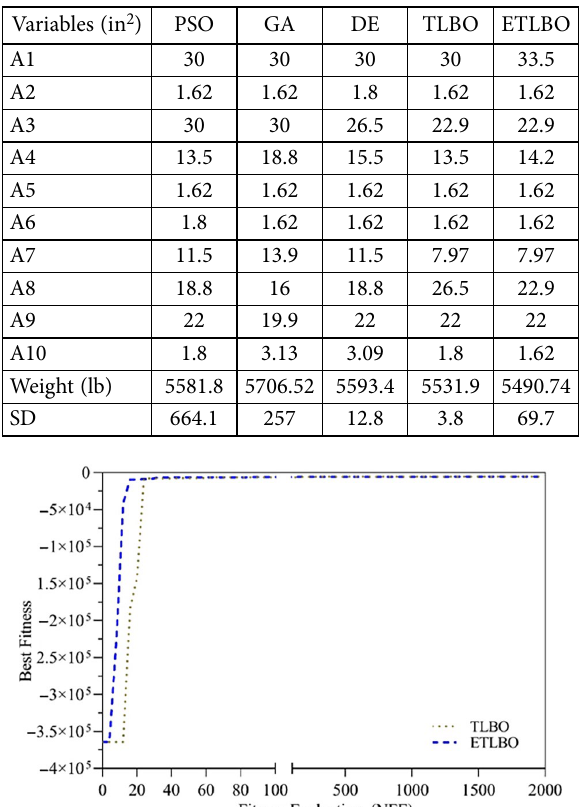
Table 1. Result of optimization algorithms 10-bar truss example